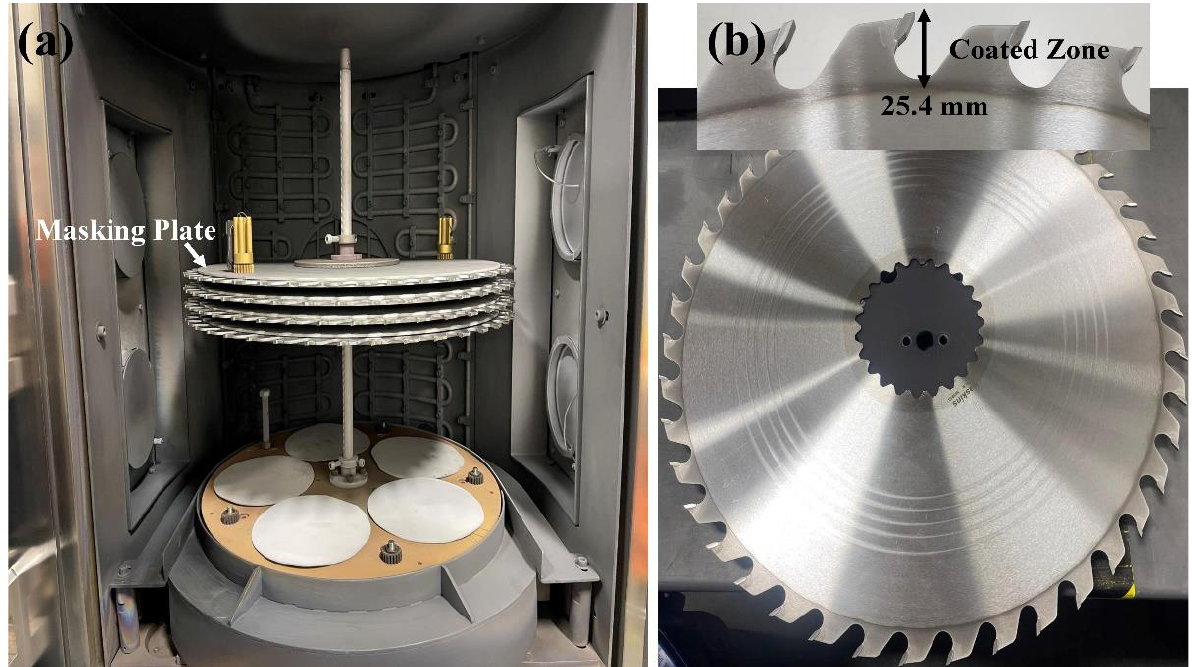
Figure 2. ( a ) Set-up of saws at the chamber of PVD coating system, ( b ) Coated zone on a circular saw.